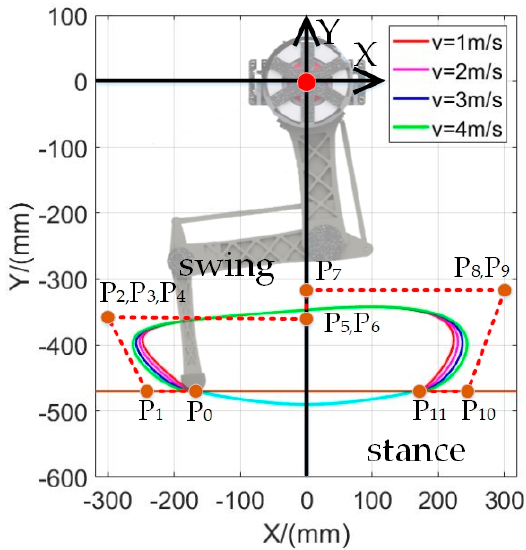
Figure 12. The B é zier curve trajectory. Figure 12. The Bézier curve trajectory. Table 2. The 12-control point of Bézier curve.